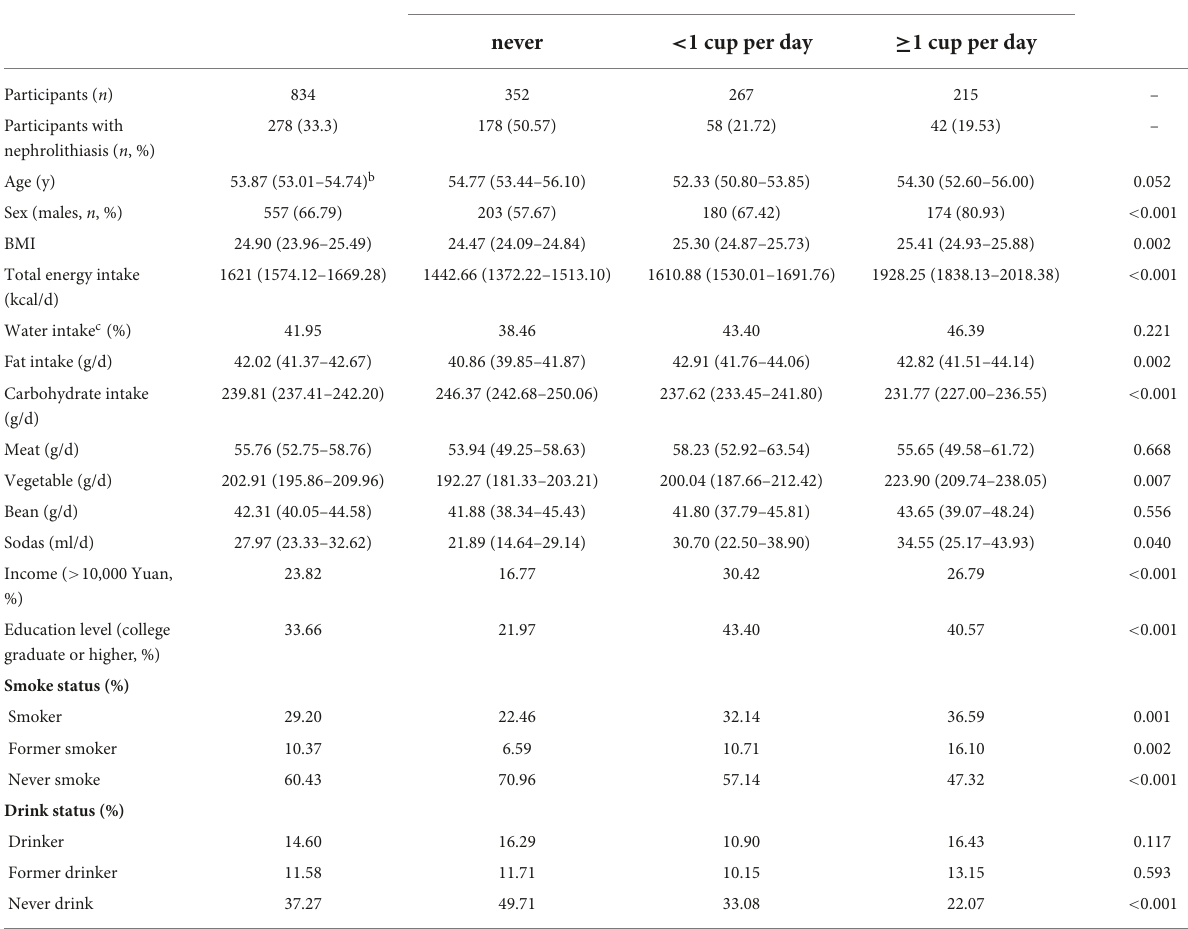
TABLE 1 Characteristics of participants by frequency of dietary tea